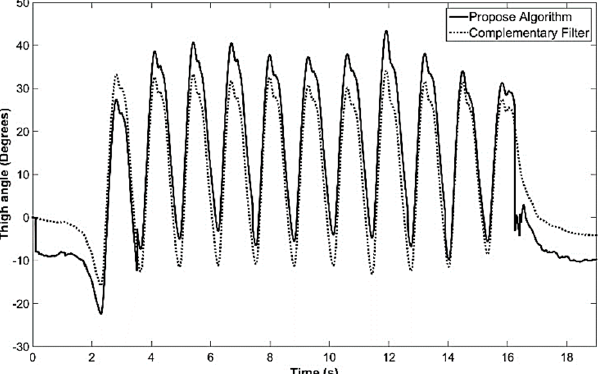
Figure 10. Thigh angle estimated in real-time in the IMU by GIOF and complementary filter captured for a trial when walking on a corridor.